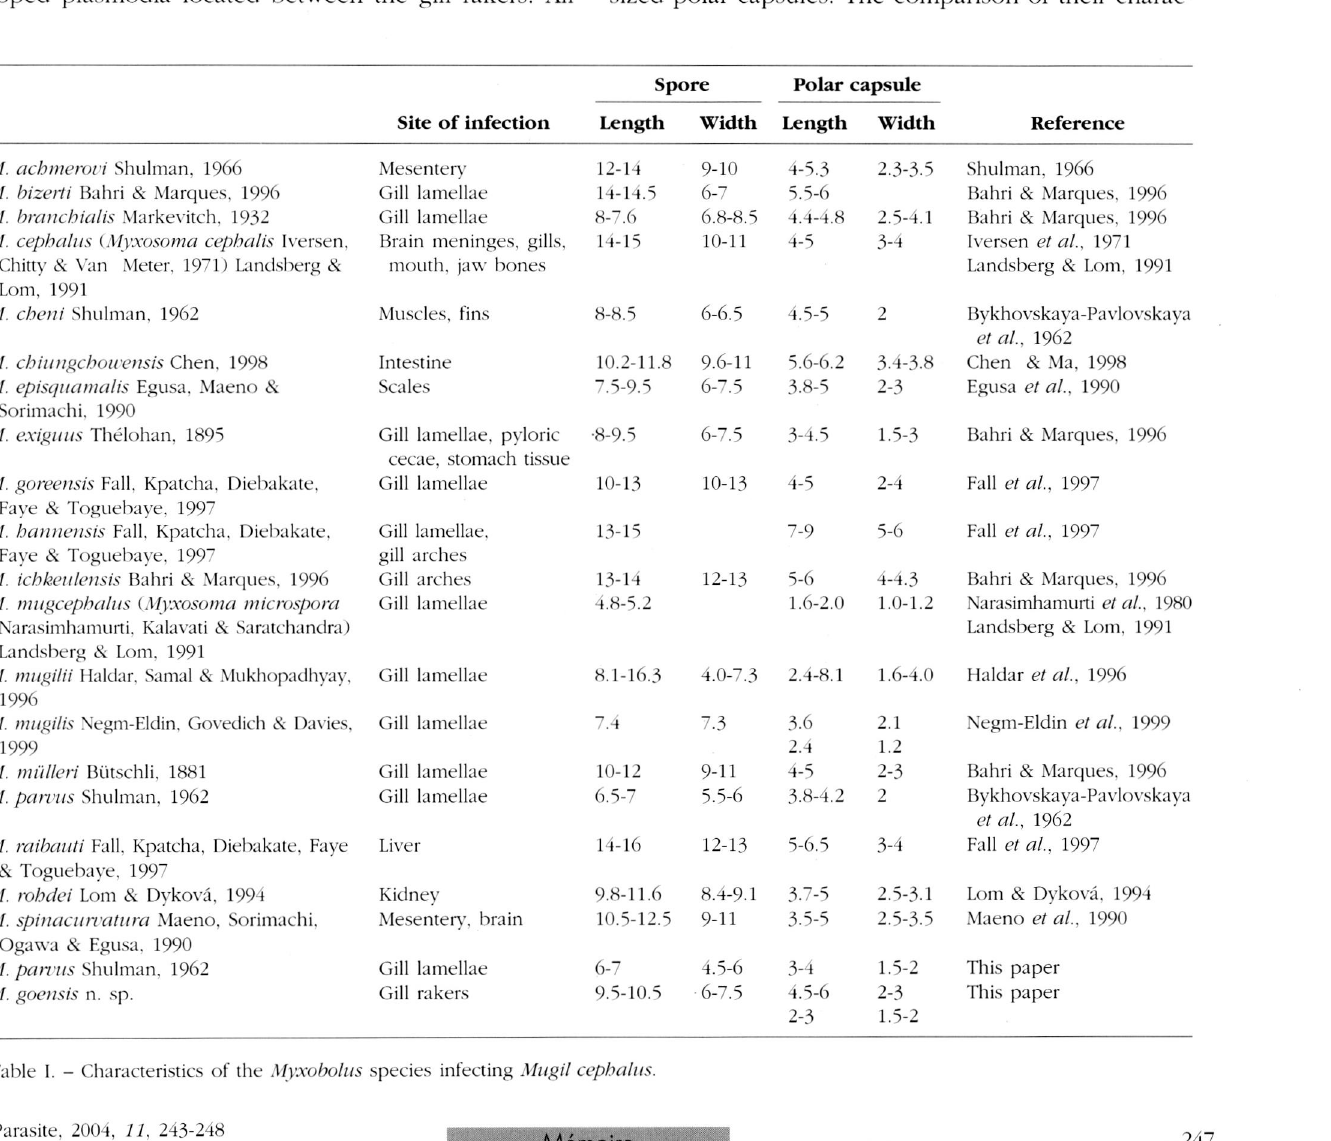
Table I. - Characteristics of the Myxobolus species infecting Mugil